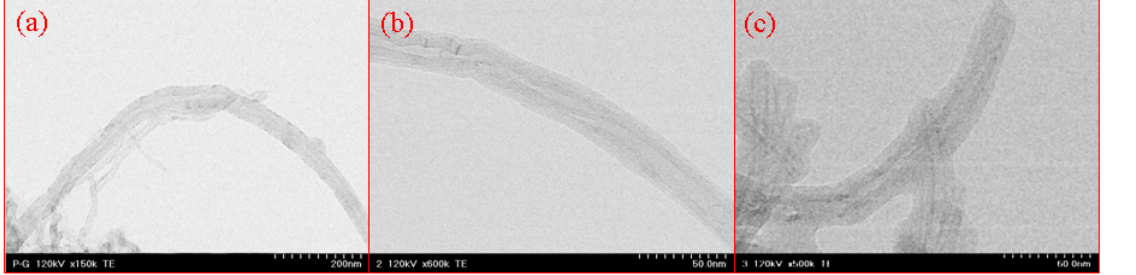
Figure 1. TEM images of pure MWNT (a), poly(GMA)-g-MWNT (b) and MWNT ionic liquid (c).